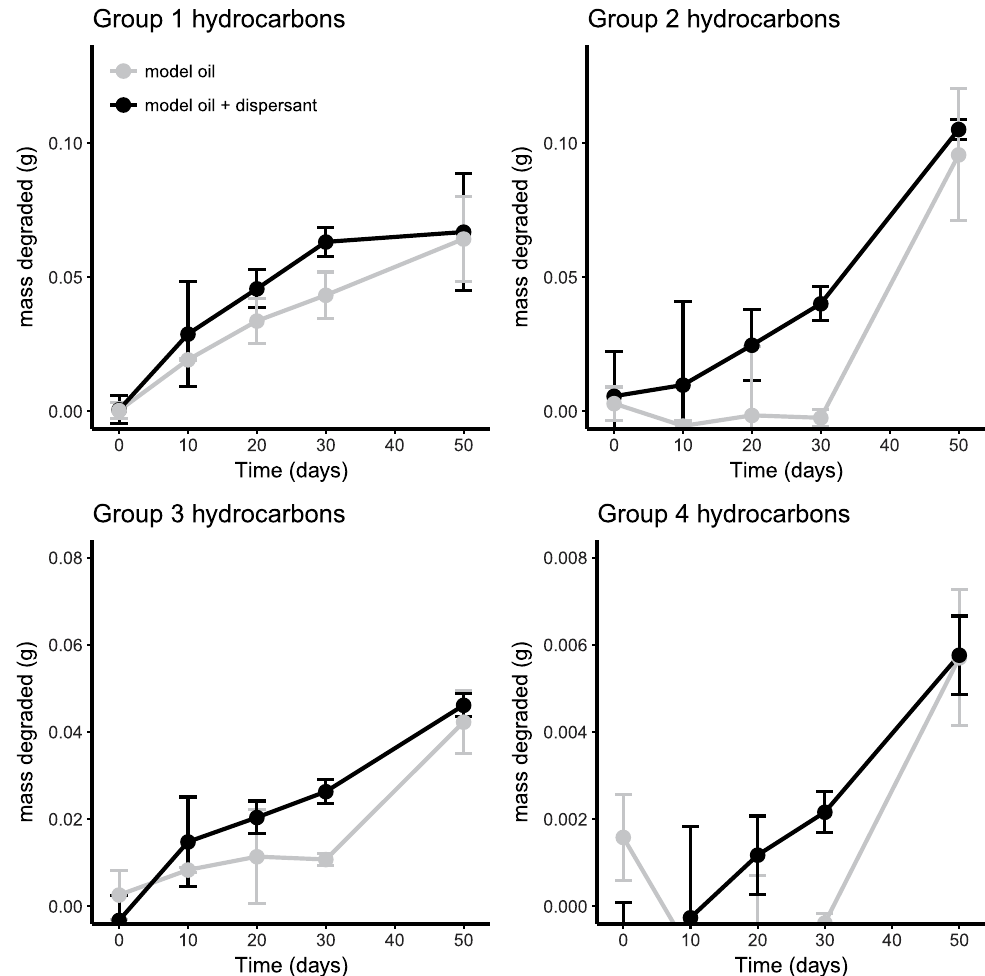
Figure 1. Mass of each aliphatic hydrocarbon group degraded during slurry incubations in FSC500 at 5 °C. Error bars are standard deviation, n = 3. Black lines are model oil and grey are model oil +